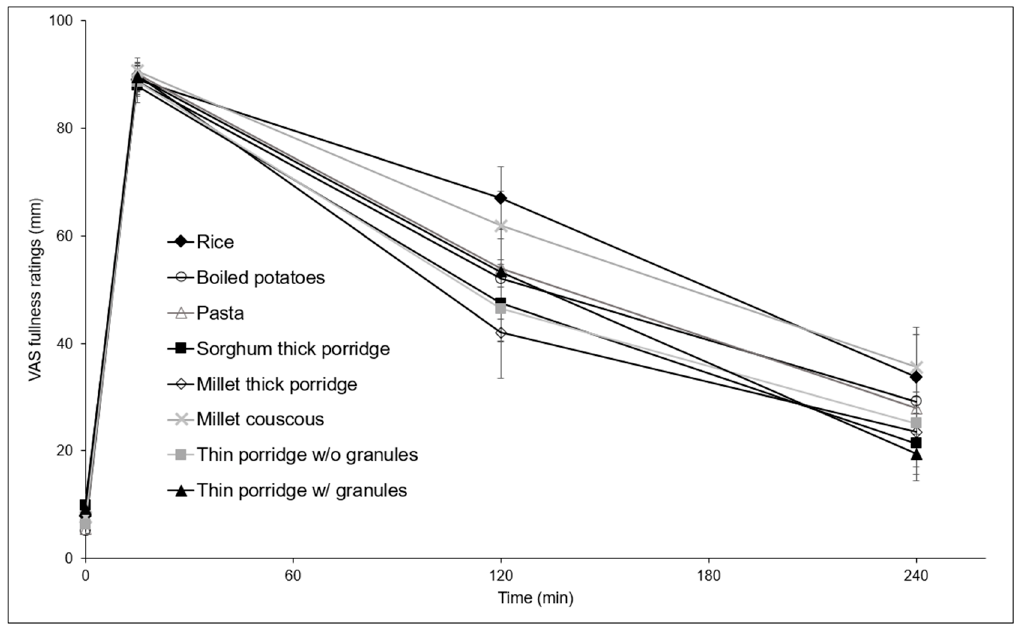
Figure 3. Mean subjective fullness ratings after ingestion of the different solid test meals (error bars (SEM), n = 14). VAS, visual analogue scales. w/o = without, w/ = with. Nutrients 2018 , 10 , x FOR PEER REVIEW